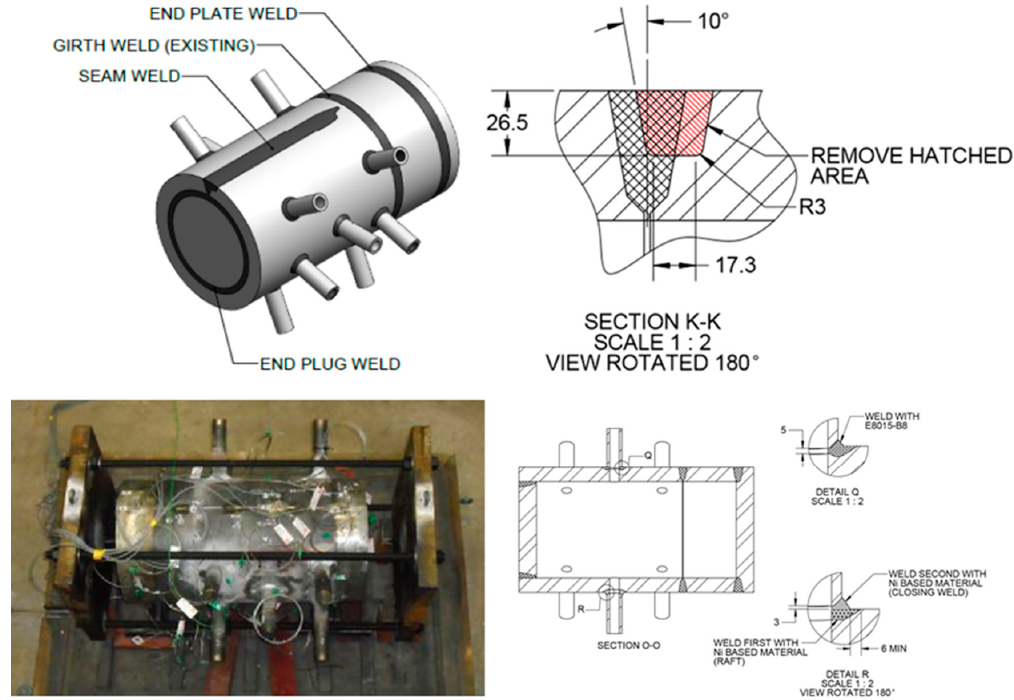
Figure 14. Example of a feature test cross weld specimens used by EPRI, ( A ) containing a simulated weld repair and ( B ) showing HAZ creep damage in a dissimilar metal repair weld between Grade 91 and Grade 22 Steels.